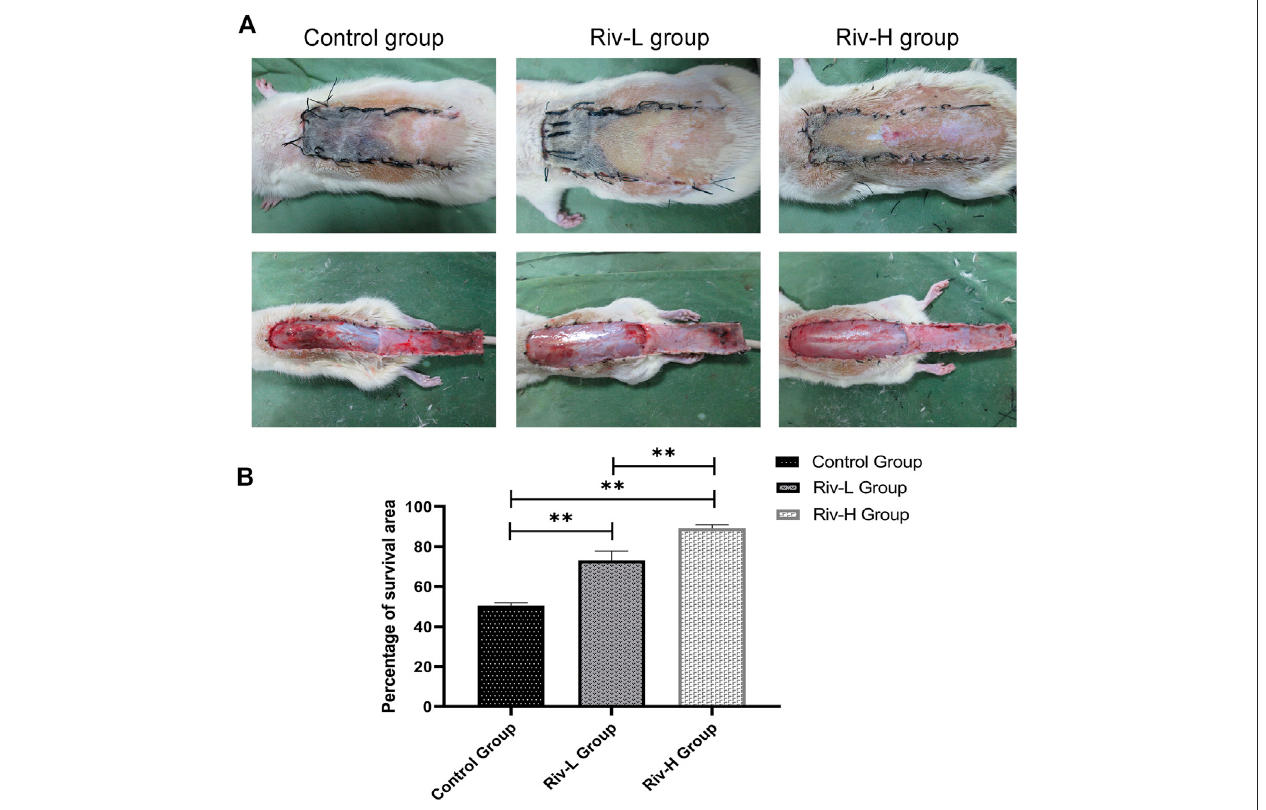
FIGURE2|(A) Macroscopicobservationoftherandom fl aponthebackofaratonday7aftersurgery(externalandafterthe fl aphasbeenlifted).Necroticskin fl aps become burnt black and rough, and the surviving skin fl aps are soft and have hair growth. (B) Comparison of fl ap survival rate among the three groups. ** p < 0.01.